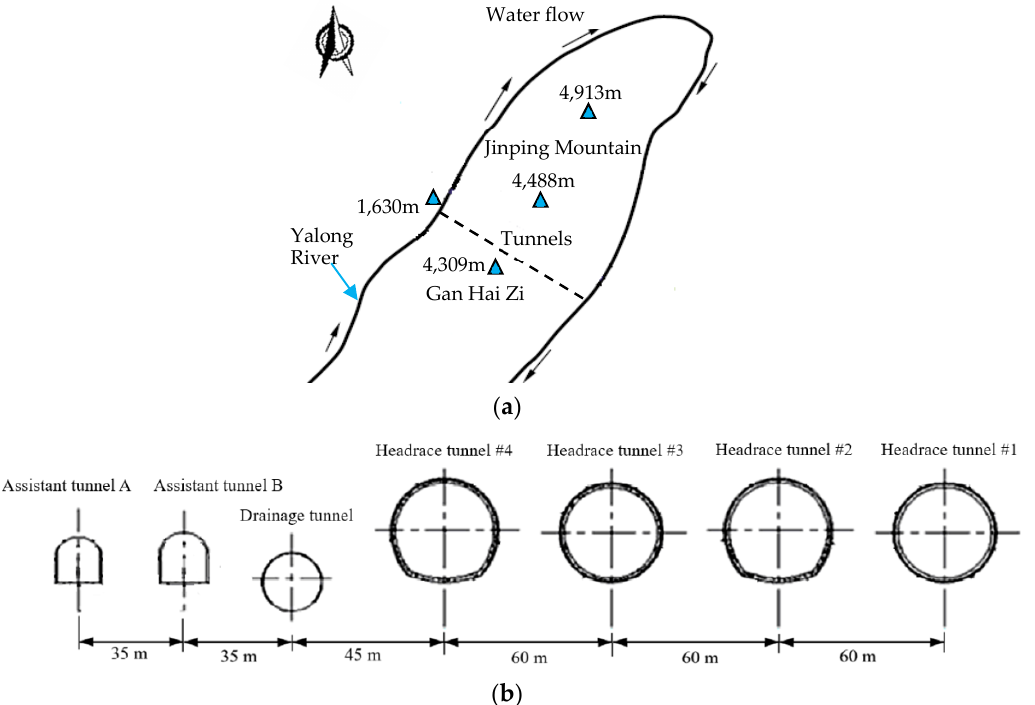
Figure 2. Details of the Jinping II hydropower station, showing: ( a ) the general layout of the power station with respect to the mountains and Yalong River; ( b ) the arrangement and cross-section of the deep tunnels therein [16].